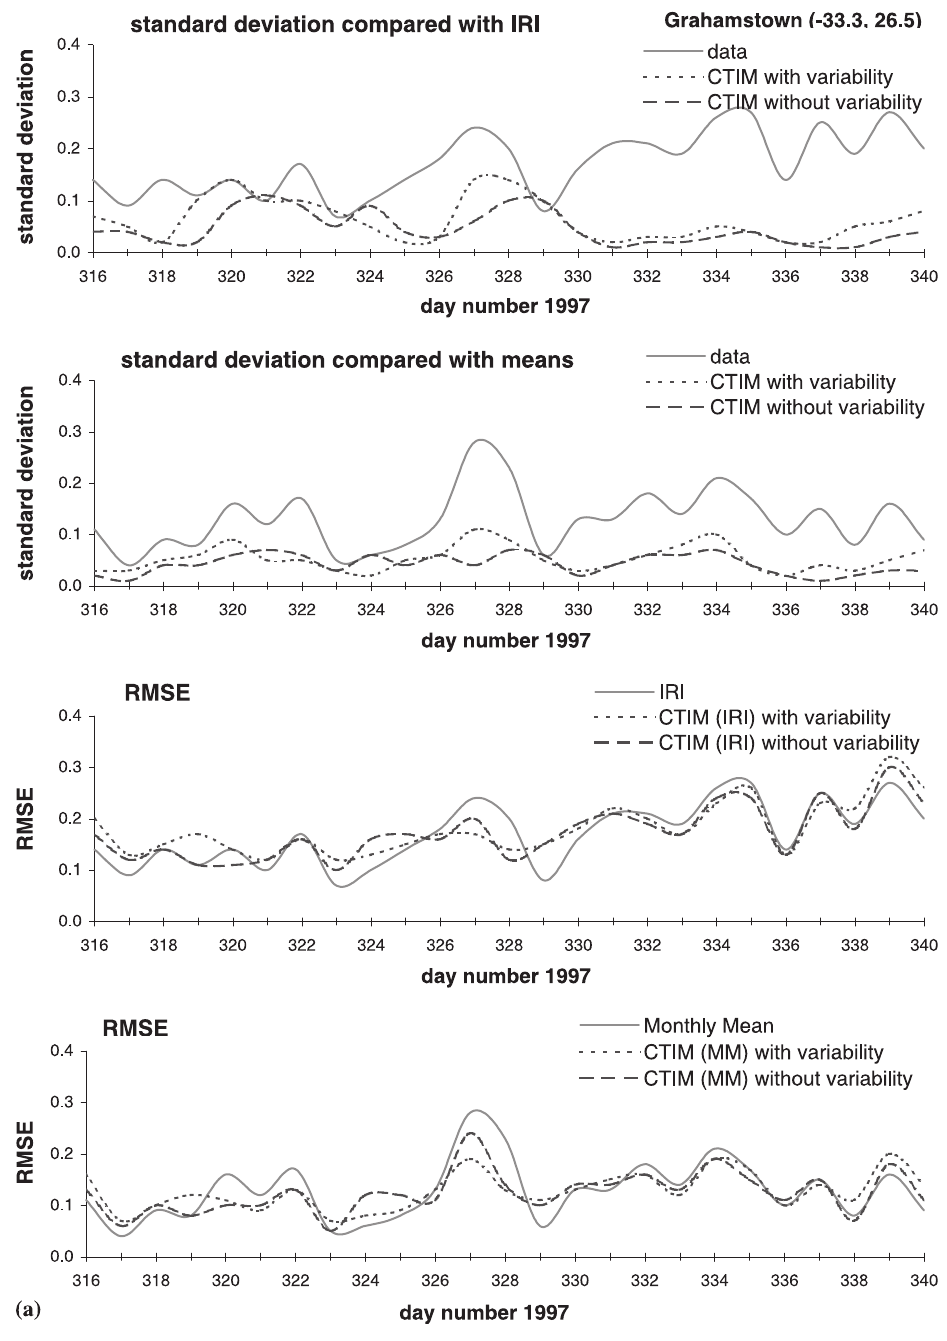
Fig. 7a, b. Same as Fig. 4 but